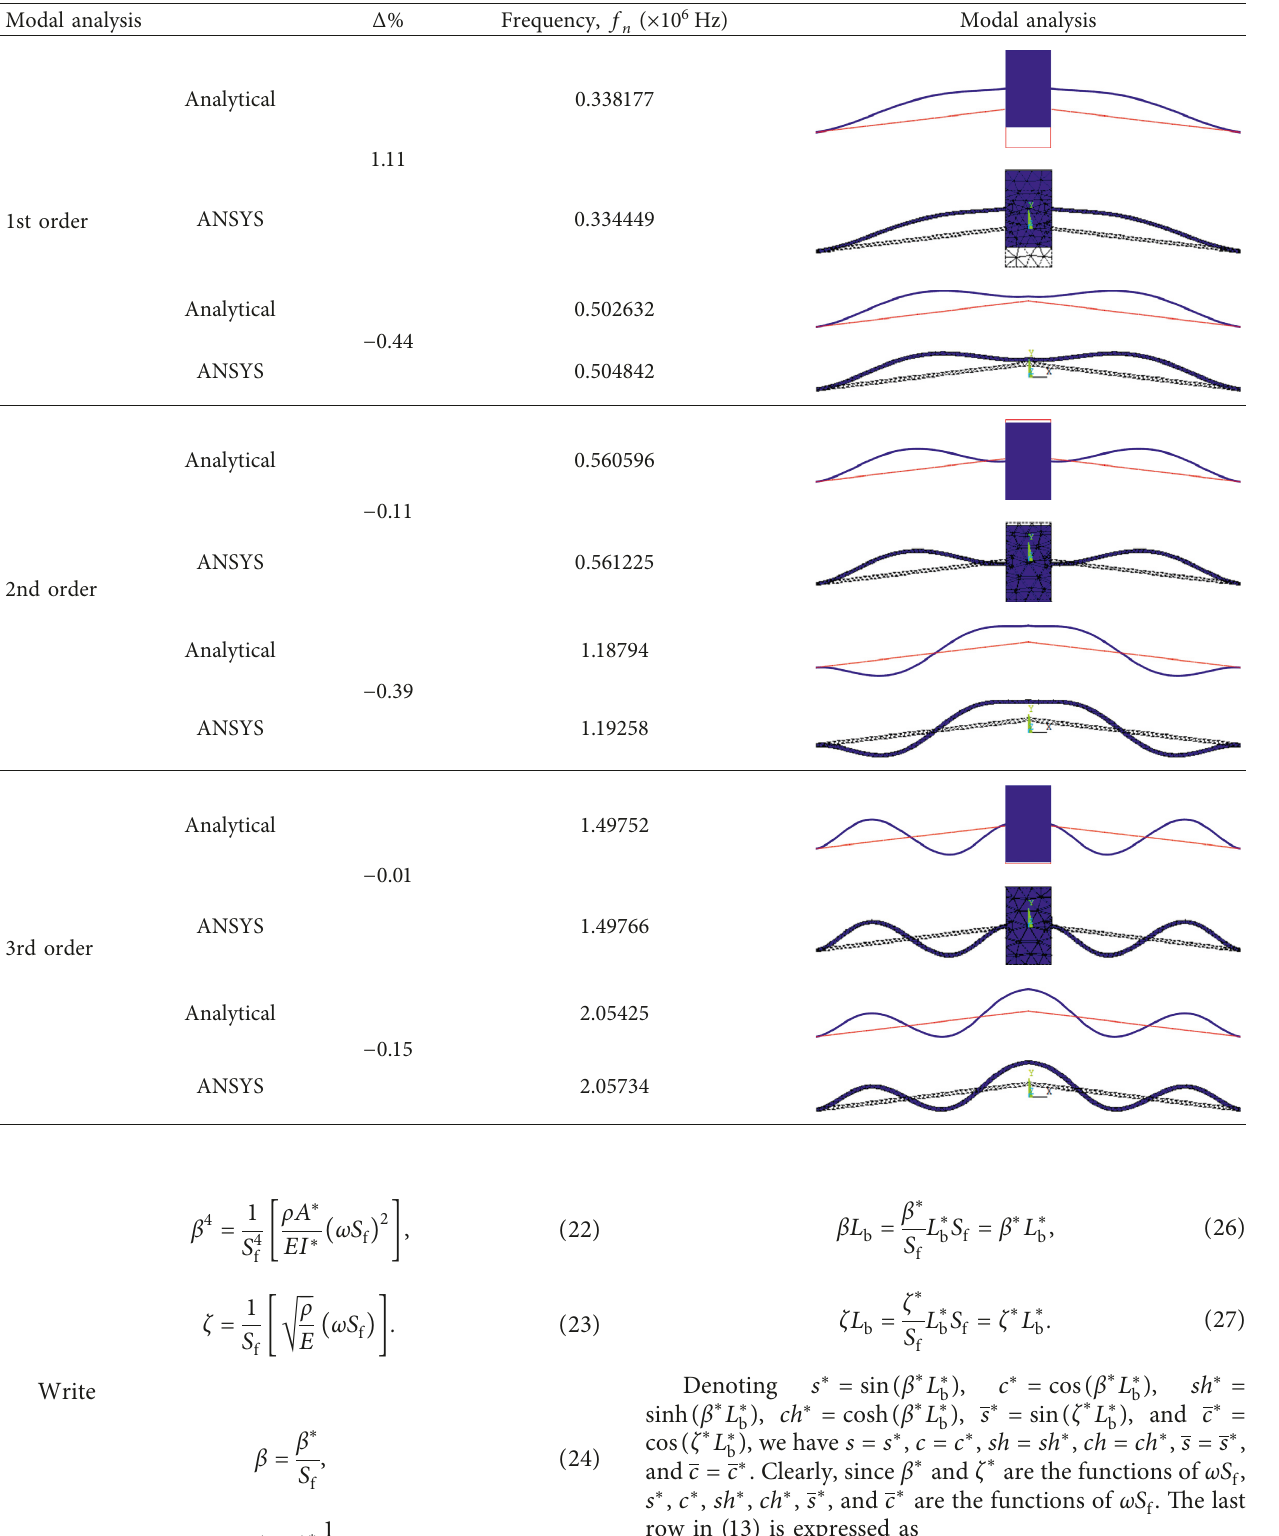
Table 3: Comparison between analytical and simulation